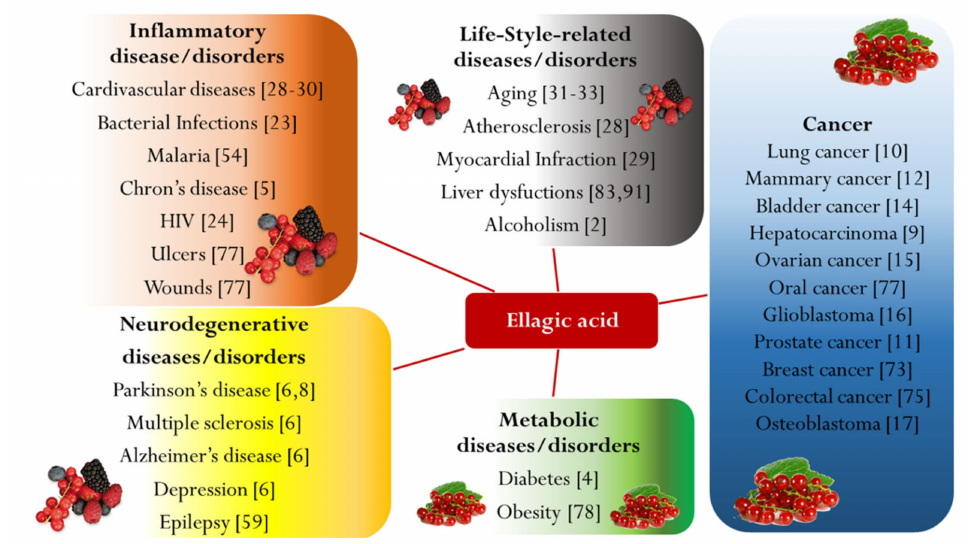
Figure 2. An overview of di ff erent ellagic acid’s activities versus human